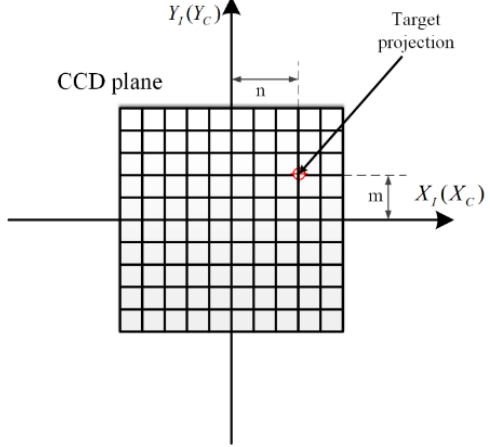
Figure 6. Target projection point position.